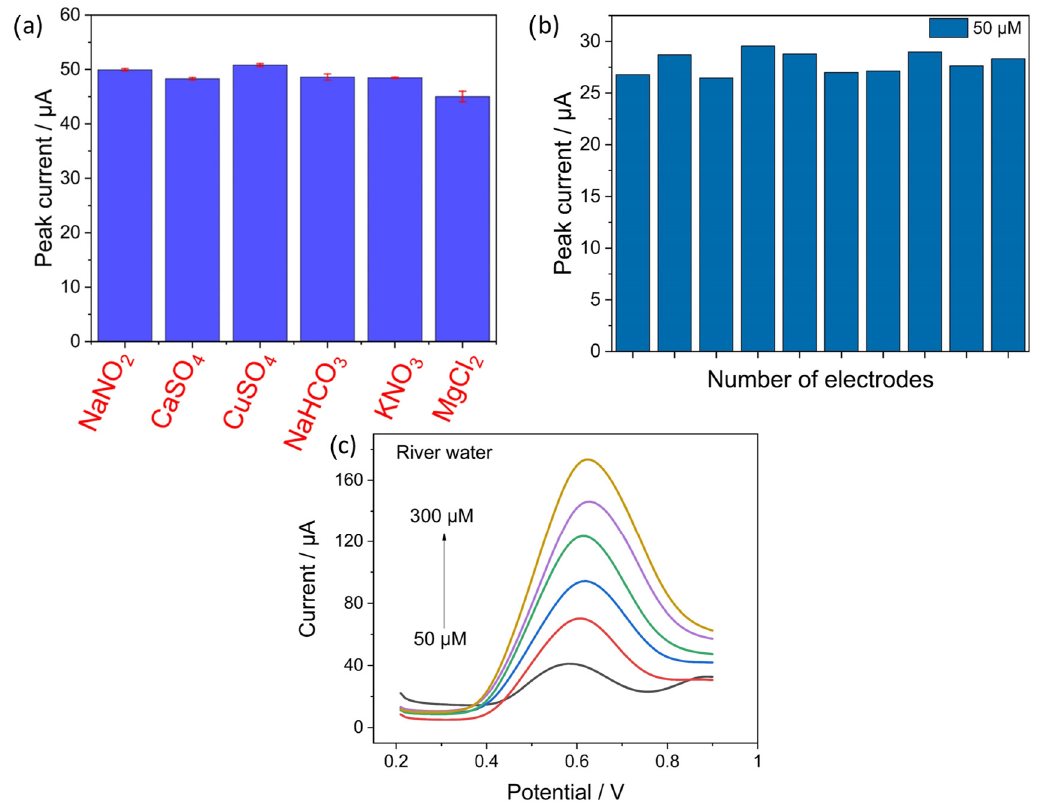
Figure 8. Square wave voltammetric curves at different concentrations from 1µM to 300µM in dif- Figure 8. ( a ) Selectivity studies of EdAu/SPCE electrode with possible interferences of concentrations ferent colors for ( a ) PalmSens, ( b ) MSTStat, and ( c , d ) the calibration curves with the linear regression 50 times higher than nitrite, ( b ) reproducibility of ten electrodes towards nitrite of 50 µ M concentration equation for PalmSens and MSTStat respectively. and ( c ) shows the response of the developed electrode in